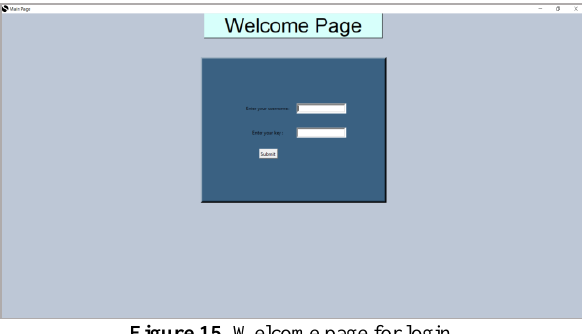
Figure 15 . Welcome page for